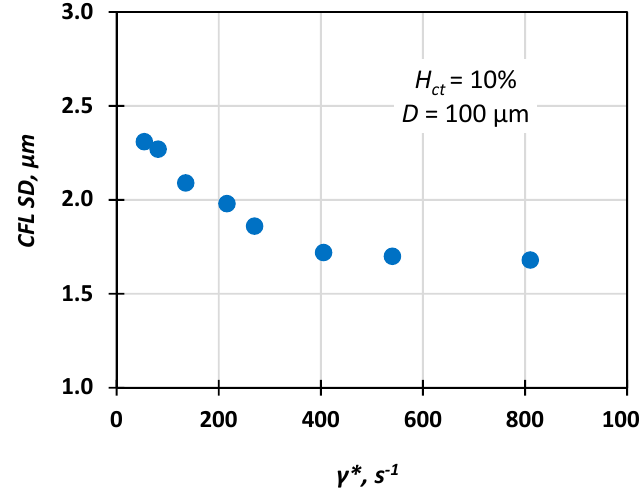
= 0.3 and 1.0 mL / h; H = 20%, D = 100 µ m (wall y = 0 µ m). ct